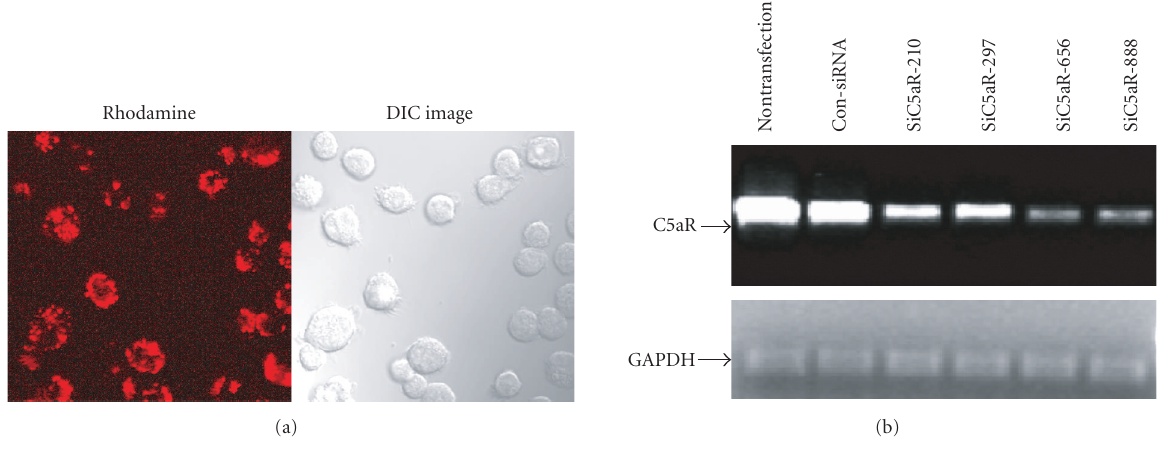
Figure 1: Screening of functional mouse C5aR siRNA oligos in MHS cells. MHS cells in 6-well plates were transfected with 30pmol of control siRNA and four C5aR siRNA oligos using Mirus TransIT-TKO transfection reagent. (a) Eight hours after transfection, cells transfected with Rhodamine-labeled control siRNA were plated on glass-bottom plate and washed twice with phenol-red-free medium and subjected to confocal microscopy analysis (Zeiss). The transfected cells were visualized by red fluorescence (left). (b) Total RNA extracted from transfected MHS cells was quantified for C5aR mRNA expression by semiquantitative one-step RT-PCR (upper panel). GAPDH was used as endogenous control (lower